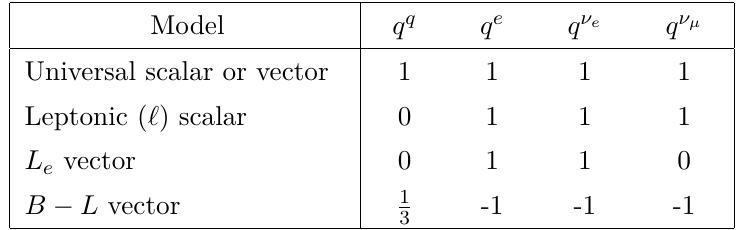
Table 2 . Charges for the scalar and vector mediator models considered in this work. corresponding neutrino-nucleus elastic scattering cross section, up to order O (( E